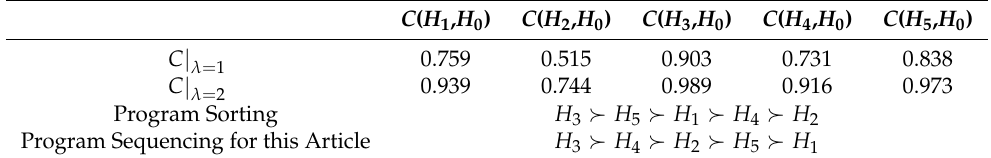
Table 7. The correlation coefficients and ranking results of all the